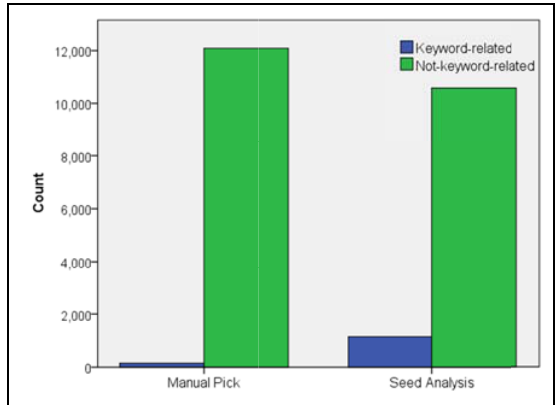
Fig. 5 Grap Organizin weight allows Table 4 illust result using user’s